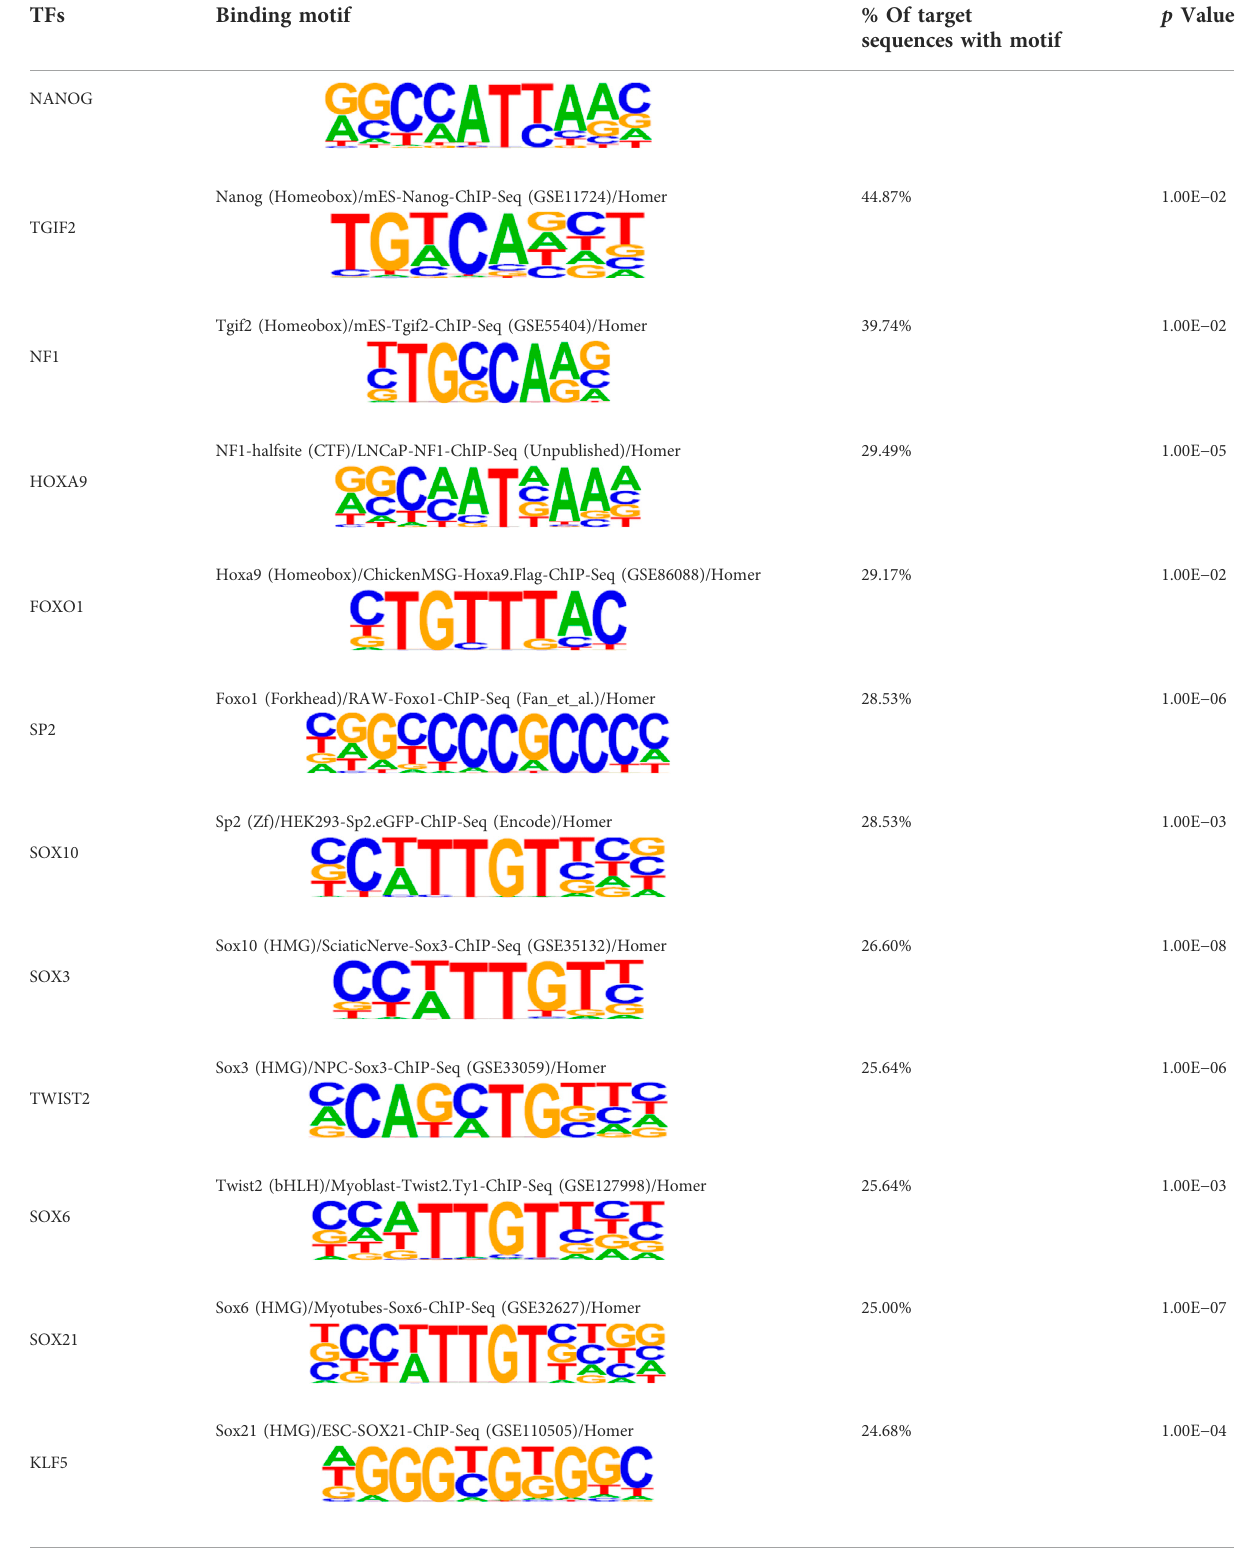
TABLE 2 TFs binding homer known motifs enriched in chromatin region in response to progestin in PIS group compared to PS group from Analysis